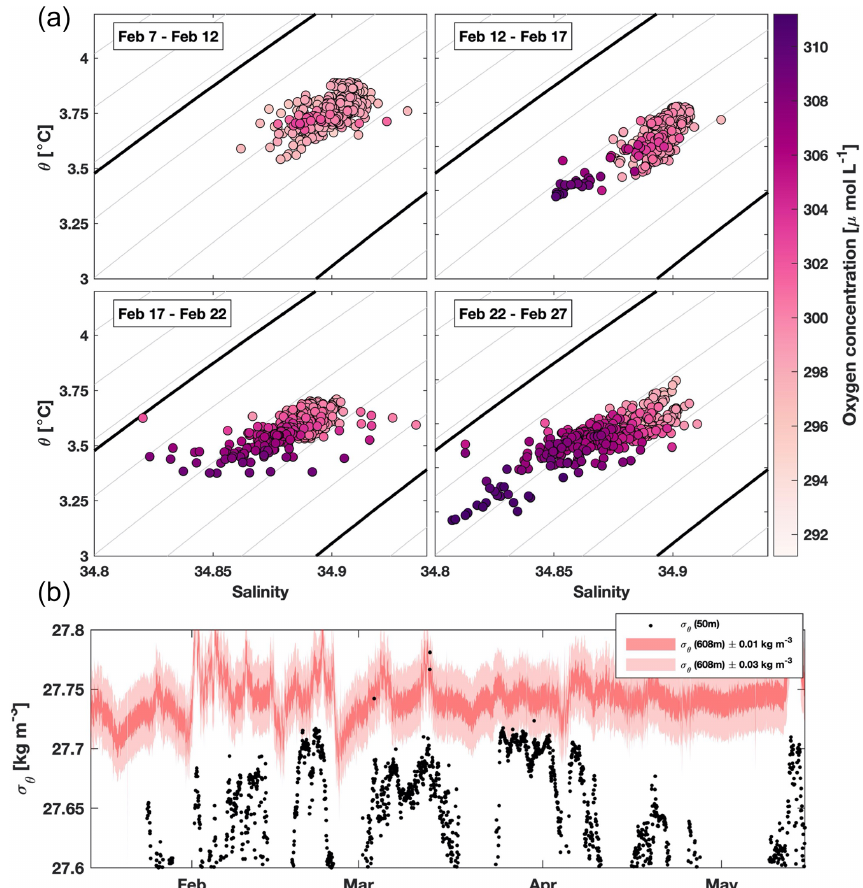
Figure 6. (a) T – S properties at K9 at 15min resolution for four consecutive 5d periods during the initial oxygen increase in February. Colors correspond to oxygen concentration. Potential density ( σ θ ) contours are drawn with a spacing of 0.025kgm − 3 , and solid black contours show densities of σ θ = 27 . 68 and σ θ = 27 . 8kgm − 3 . Note changed axis ranges compared to Fig. 5. (b) Density measurements at K8 at 50 and 608m nominal depth. Shading for 608m values shows density ranges of ± 0.01 and ± 0.03kgm − 3 from the measured